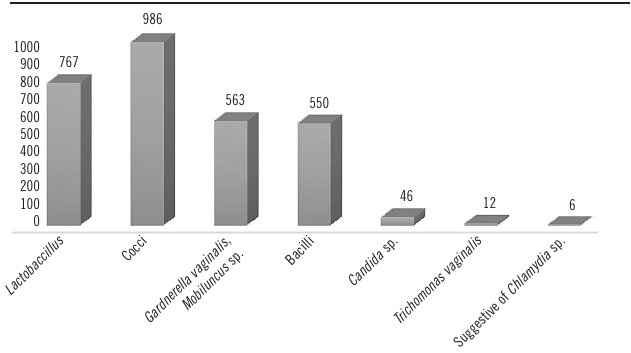
figurE − Microorganisms found in cytological